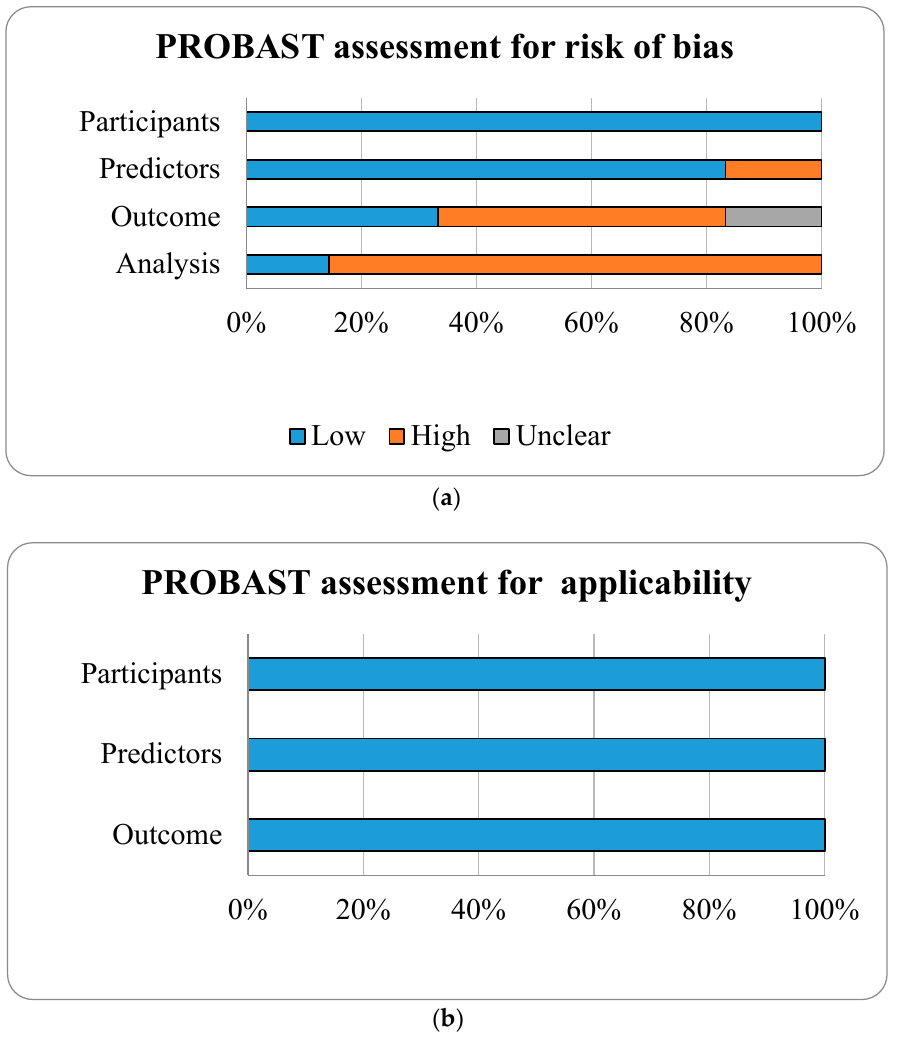
Figure 2. Risk of bias assessment ( a ) and applicability ( b ) using the Prediction model Risk of Bias Assessment Tool (PROBAST) based on four domains of prognostic models for outcome prediction in gestational obstructive sleep apnea. Table 3. Tabular Presentation for The Prediction model Risk of Bias Assessment Tool (PROBAST) Results of studies of gestational obstructive sleep apnea.